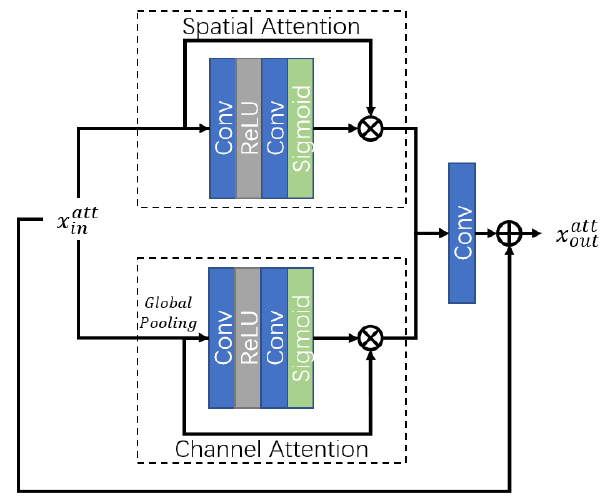
Figure 4. Block design of SACA.